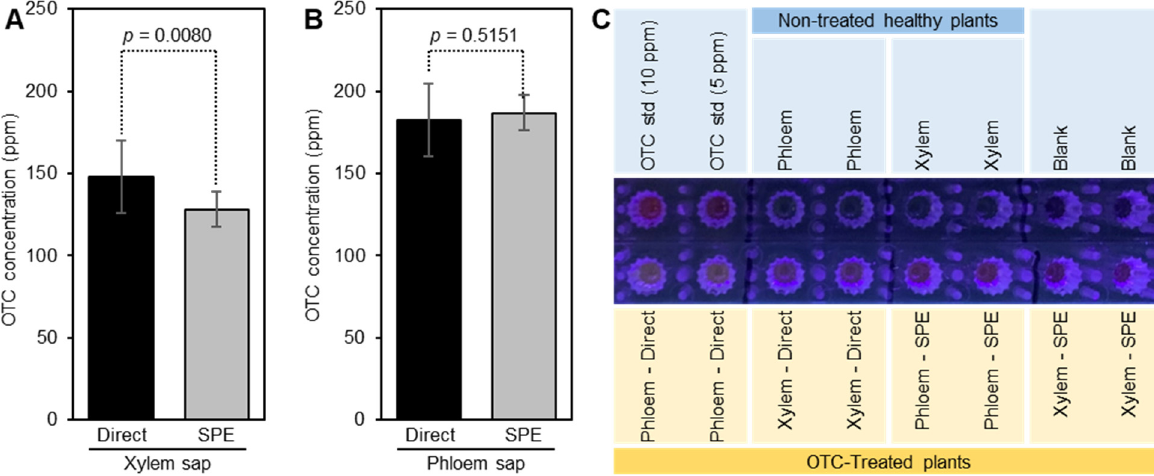
Figure 6. Determination and visualization of OTC in the phloem and xylem saps of OTC-treated plants. ( A ) The level of OTC in the xylem sap as measured using the direct method (without SPE) and after SPE. ( B ) The level of OTC in the phloem sap as measured using the direct method (without SPE) and after SPE. Data are the means ± SD of five replicates ( n = 5). Values with p -values < 0.05 are significantly different using a two-tailed student t -test. ( C ) Fluorescence imaging of OTC in standards and phloem and xylem saps of OTC-treated plants. Saps were obtained by centrifugation and extracted using 1 M HCl containing 2.2% trichloroacetic acid, and either cleaned using SPE or measured directly. Samples were placed in a 96-well microplate and their image was taken under ultraviolet light (400